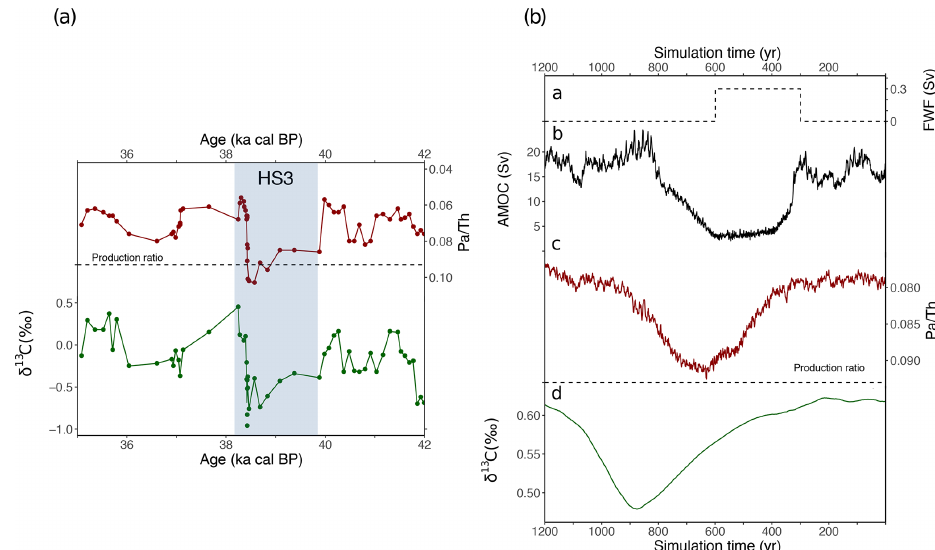
Figure 6. Example of the Bermuda Rise time series. (a) Pa / Th and benthic δ 13 C (‰) measured at the Bermuda Rise around HS4 (Henry et al., 2016). (b) Modelled time series corresponding to the average of the nine grid cells surrounding the model grid cell closest to the Bermuda Rise (34 ◦ N, 58 ◦ W). (a) Imposed freshwater flux, (b) Maximum North Atlantic meridional stream function (Sv), (c) simulated Pa / Th and (d) benthic δ 13 C